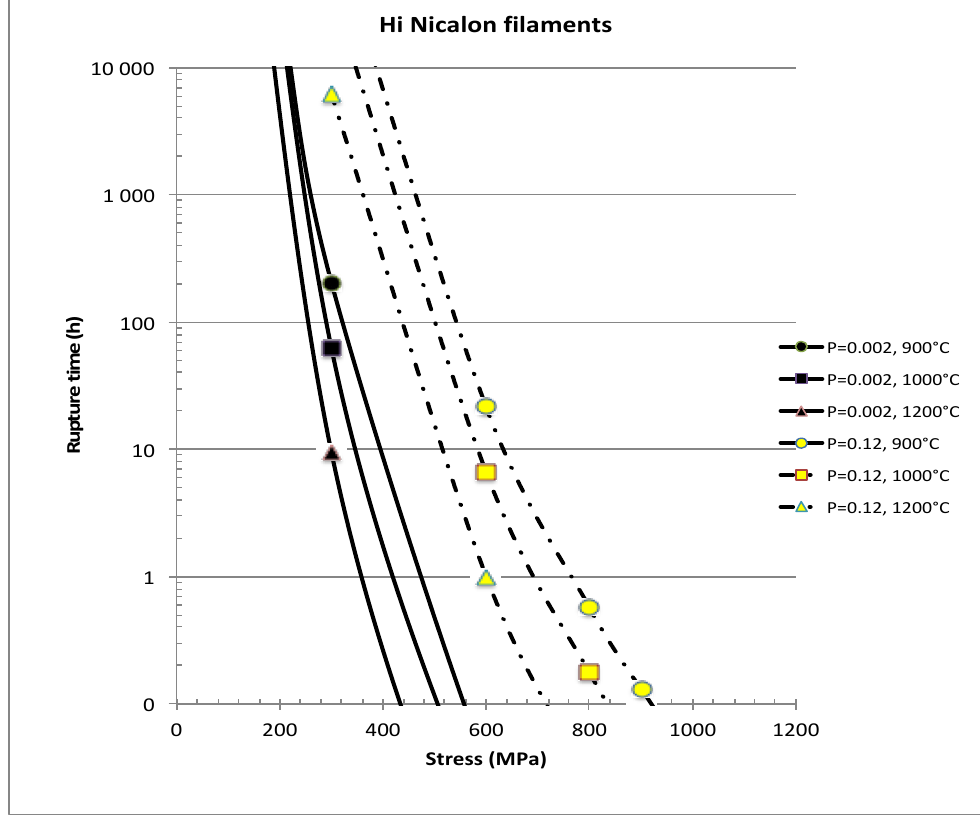
Figure 7. Influence of temperature on the lower and upper bounds of stress–rupture time diagrams for composites. Table 4. Estimates of stress exponent p and constant A at temperatures for Hi Nicalon fiber tows